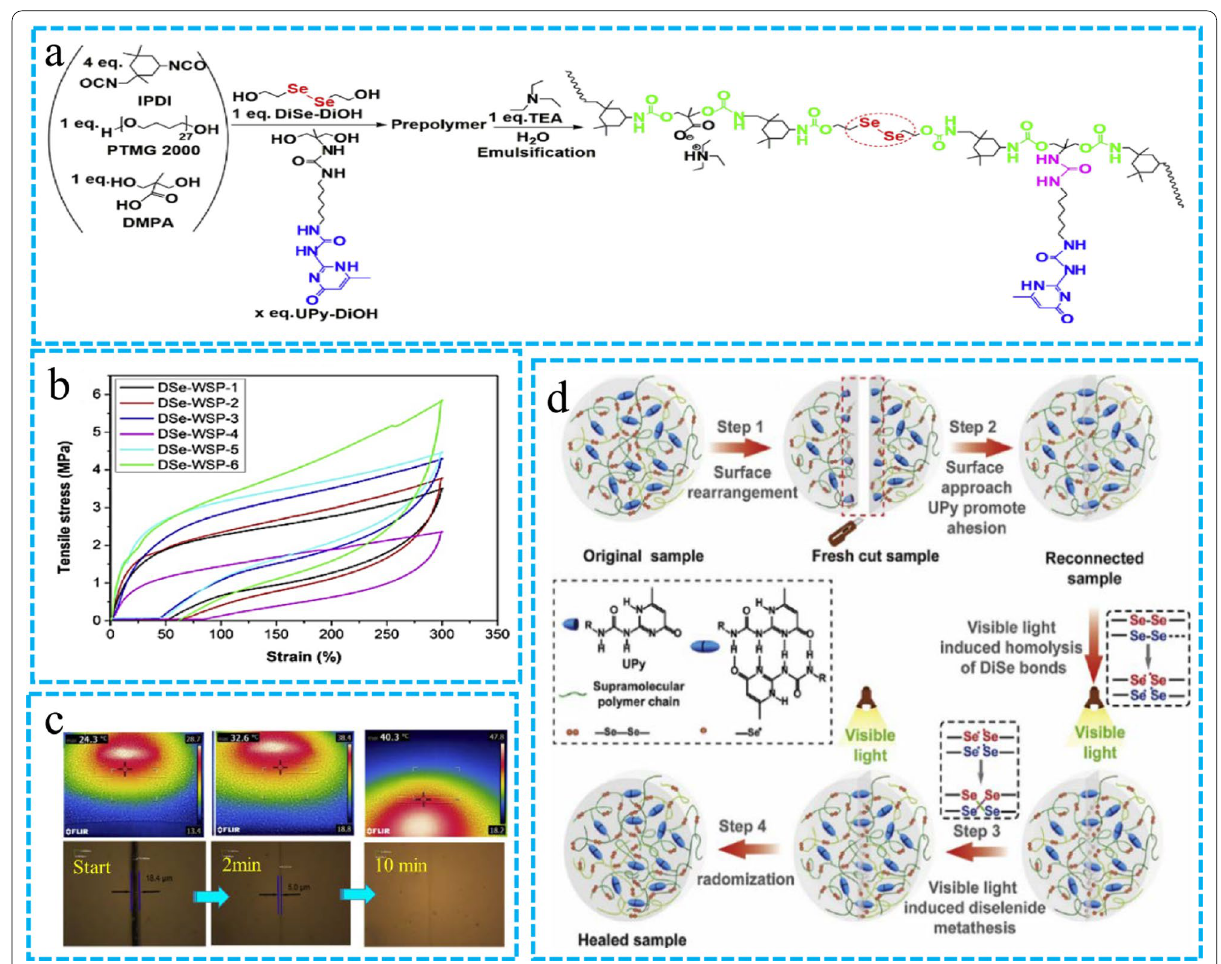
Fig. 12 a The chemical structure of DSe-WSPs polymers. b Loading/unloading curves of DSe-WSPs polymers under a strain of 300%. c The optical micrograph of the change of sample surface temperature and scratch with time under the stimulation of visible light. d Photoinduced